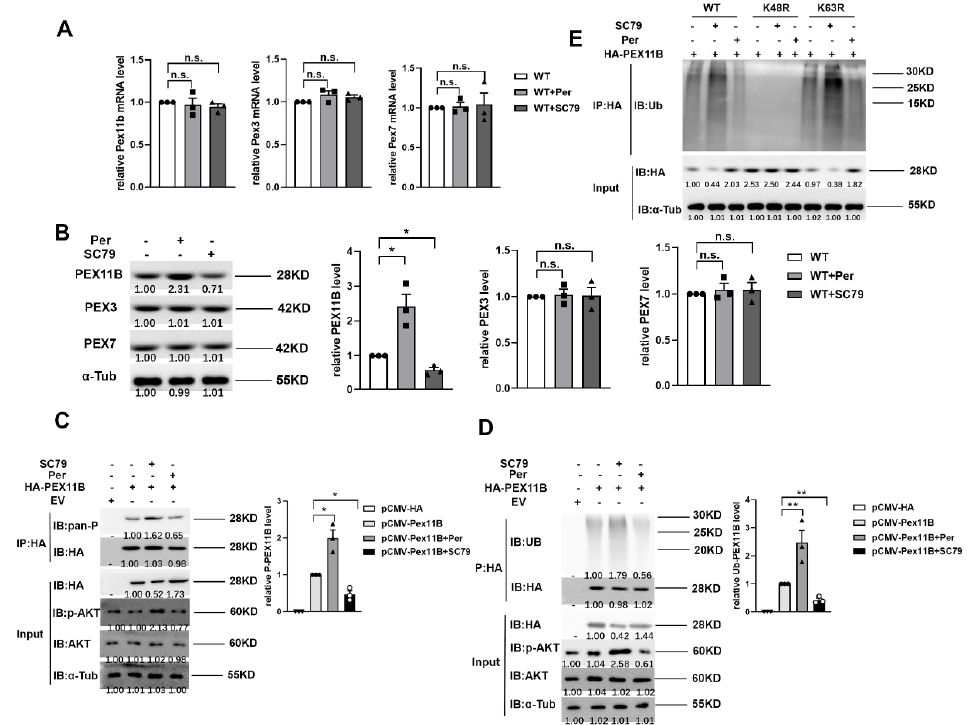
Figure 5. AKT1 phosphorylation regulates the modification and stability of PEX11B. ( A ) Wild-type RAW264.7 was pretreated with 10 µ M Perifosine for 12 h or 10 µ M SC79 for 2 h, stimulated with 300 ng/mL LPS for 24 h. qRT-PCR was used to detect the mRNA levels of PEX11B, PEX3, and PEX7. ( B ) Wild-type RAW264.7 was pretreated with 10 µ M Perifosine for 12 h or 10 µ M SC79 for 2 h, stimulated with 300 ng/mL LPS for 24 h. Western blotting was used to detect the protein levels of PEX11B, PEX3, and PEX7. ( C , D ) HA-labeled PEX11B or pCMV-HA was transfected into cells for 24 h, pretreated with 10 μ M Perifosine for 12 h or 10 μ M SC79 for 2 h, and stimulated with LPS for 24 h. The phosphorylation level ( C ) and ubiquitin level ( D ) of PEX11B were detected by Co-IP. ( E ) Cells were transfected with different ubiquitin mutants and HA-labeled PEX11B, pretreated with 10 μ M Perifosine for 12 h or 10 μ M SC79 for 2 h, and stimulated with LPS for 24 h. The interaction between PEX11B and ubiquitin was detected by Co-IP. All data are shown as mean ± s.e.m ( n = 3). n.s. not significant. One-way ANOVA followed by Bonferroni post hoc test was used for data analysis. Figure 6. ISOC1 affects the expression of inflammatory cytokines through the AKT1 /PEX11B/pe- roxisome pathway. Compared with the wild-type macrophages, ISOC1-deficient macrophages ex- hibited a hyperphosphorylation of AKT1 under the stimulation of LPS. The hyperphosphorylation